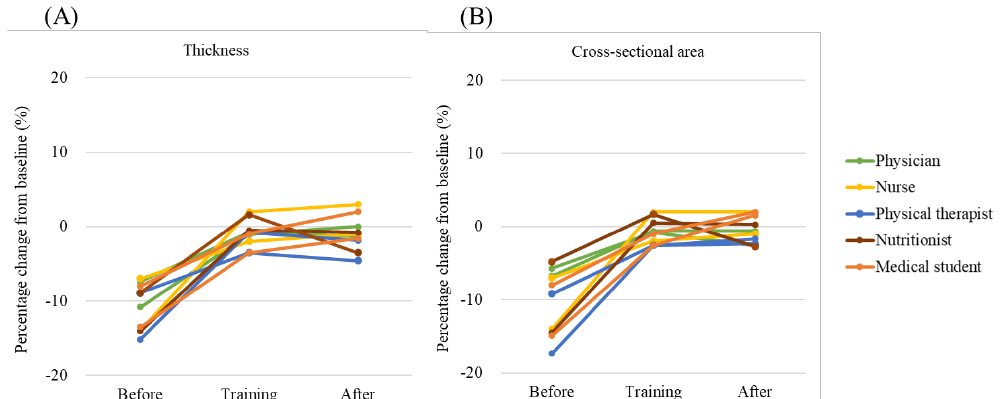
Figure 3. Measurement accuracy before and after the phantom training (Study 2-1). ( A ) Thickness. ( B ) Cross-sectional area. Statistical significance was tested using 95% confidence intervals (CIs), with intervals not including 0% considered as significantly inaccurate using JMP Statistical Software version 13.1.0 (SAS Institute Inc., Cary, NC, USA).